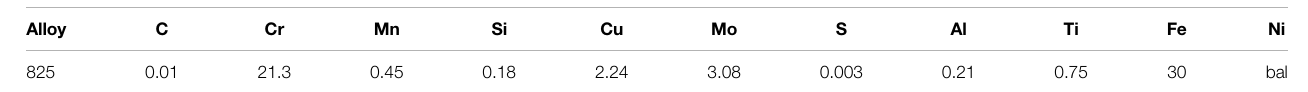
TABLE 1 | The chemical composition of 825 (wt%).